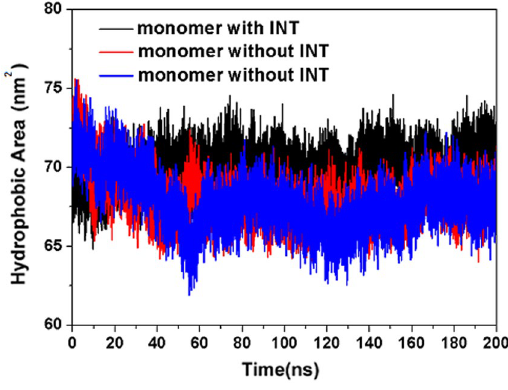
Figure 10. Hydrophobic areas of HA2 subunits with or without INT during 200 ns molecular dynamics simulations under acidic conditions.